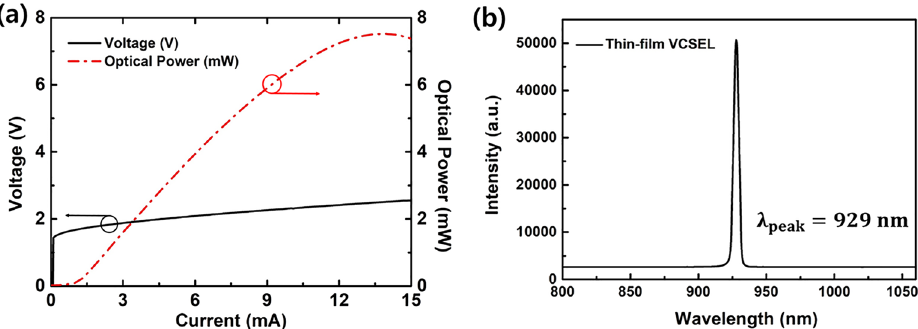
Figure 5. ( a ) L–I–V characteristics of the 930 nm top-emitting thin-film VCSELs onto PDMS. ( b ) Emission spectrum of the 930 nm top-emitting thin-film VCSELs. The threshold current and voltage of the fabricated thin-film VCSEL are 1.08 mA and 1.64 V, respectively. The maximum output power of the thin-film VCSEL is 7.52 mW at the injection current of 13.9 mA.